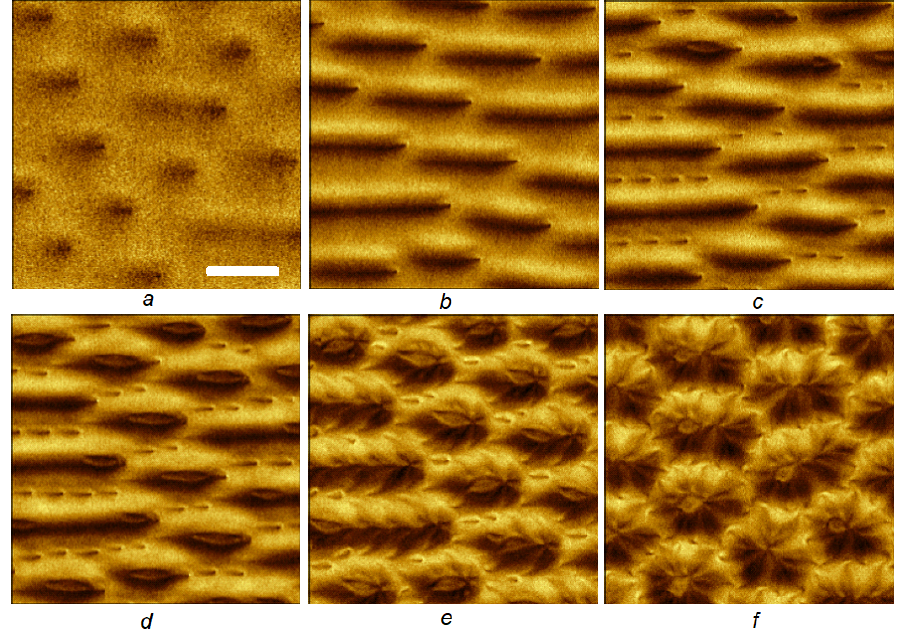
Figure 3. MFM images of the garnet film in the out-of-plane magnetic field. ( a ) H = 577 Oe, ( b ) H = 427 Oe, ( c ) H = 358 Oe, ( d ) H = 296 Oe, ( e ) H = 120 Oe, ( f ) H = 0 Oe. The scale bar corre- sponds to 5 µ